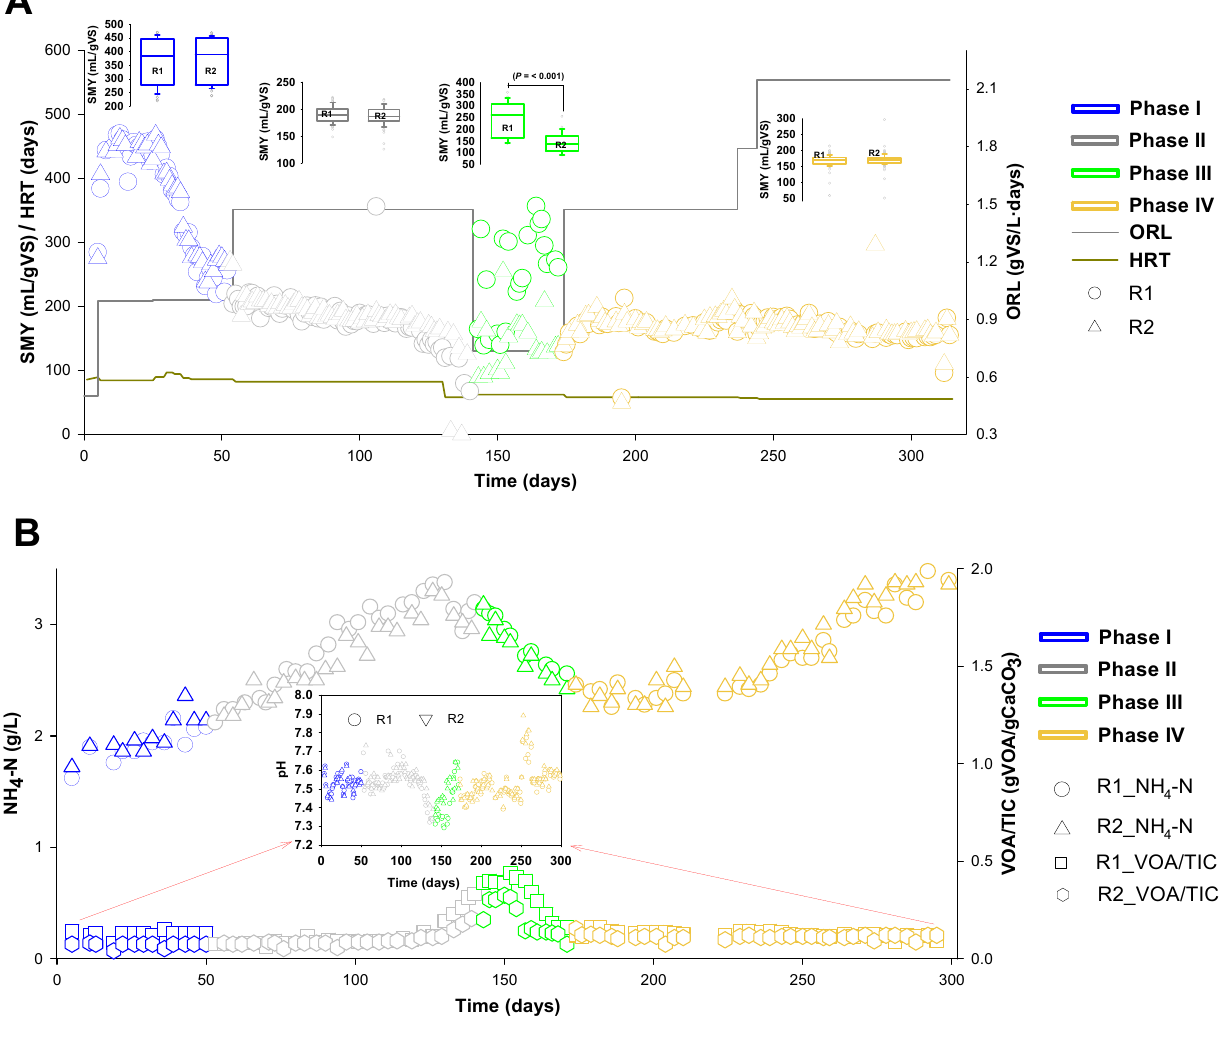
Figure 2. Anaerobic digestion (AD) process performance of the insect frass pilot plant (IF_PP) sample. Specific methane yield (SMY), organic loading rate (ORL), and hydraulic retention time (HRT) ( A ). Ammonium nitrogen (NH 4 ‐ N) concentration, ratio of volatile organic acids to total inorganic carbon (VOA/TIC) and pH ( B ).